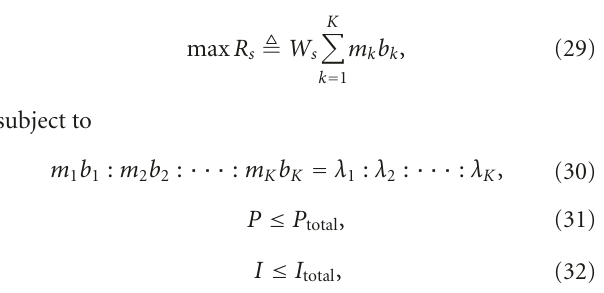
Pseudocode 2: Pseudocode for the memetic